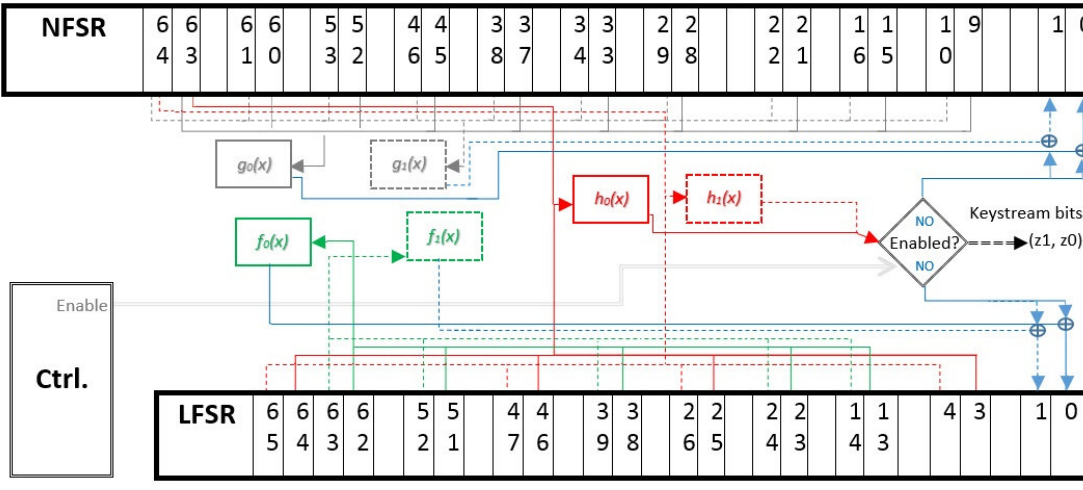
Figure 4. Grain (2 × ) architecture (unrolled